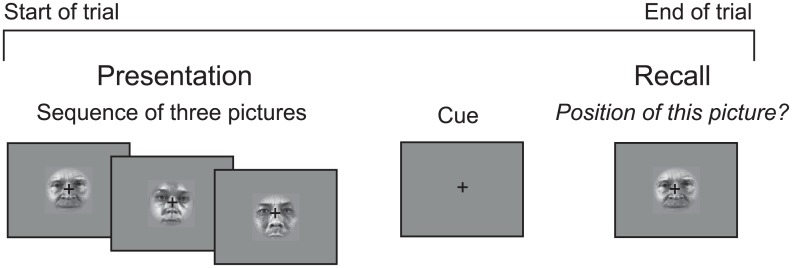
A serial recall task based on [33].